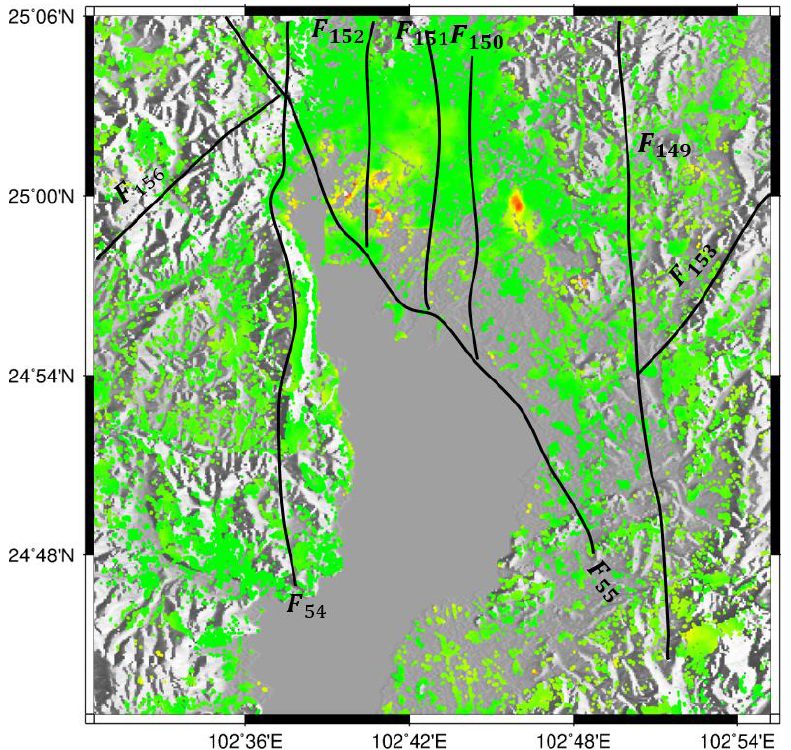
Figure 18. The relationship between ground deformation and quaternary active faults in Kunming. The black solid line shows the quaternary active faults.